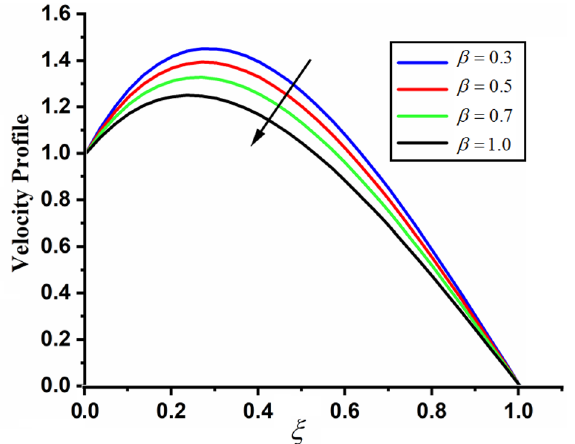
Figure 2. The impact of fractal parameter β on couple stress fluid velocity in channel when α = 0.5 , Gr = 2 , Gm = 3 , M = 2 , K = 3 , η A = 1 , P = 1.5 , Pr = 1.5 , Re = 2.5 and Sc = 0.3